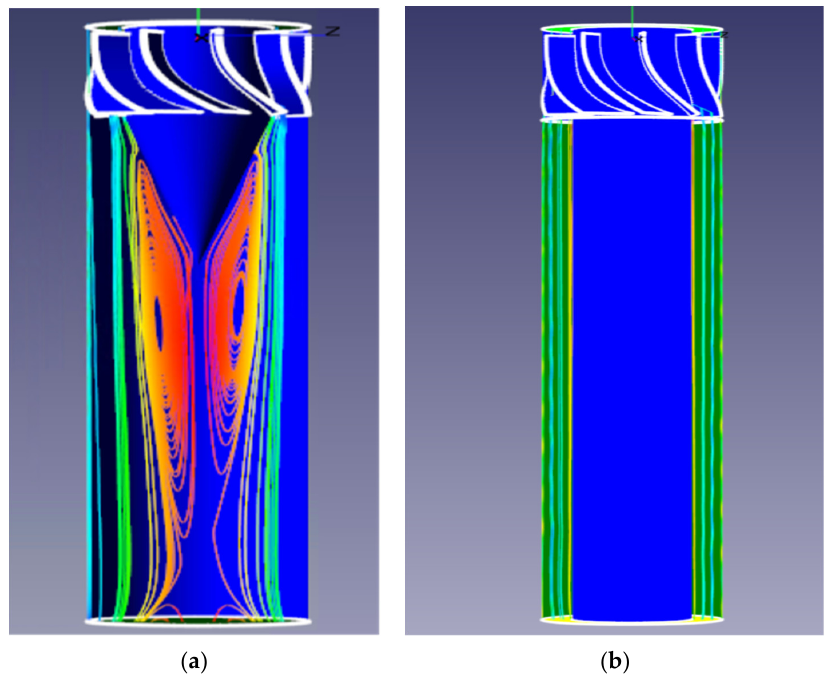
Figure 2. Gas flow in separation chambers with different stabilizer geometry: ( a ) conical; ( b ) elongated cylindrical.